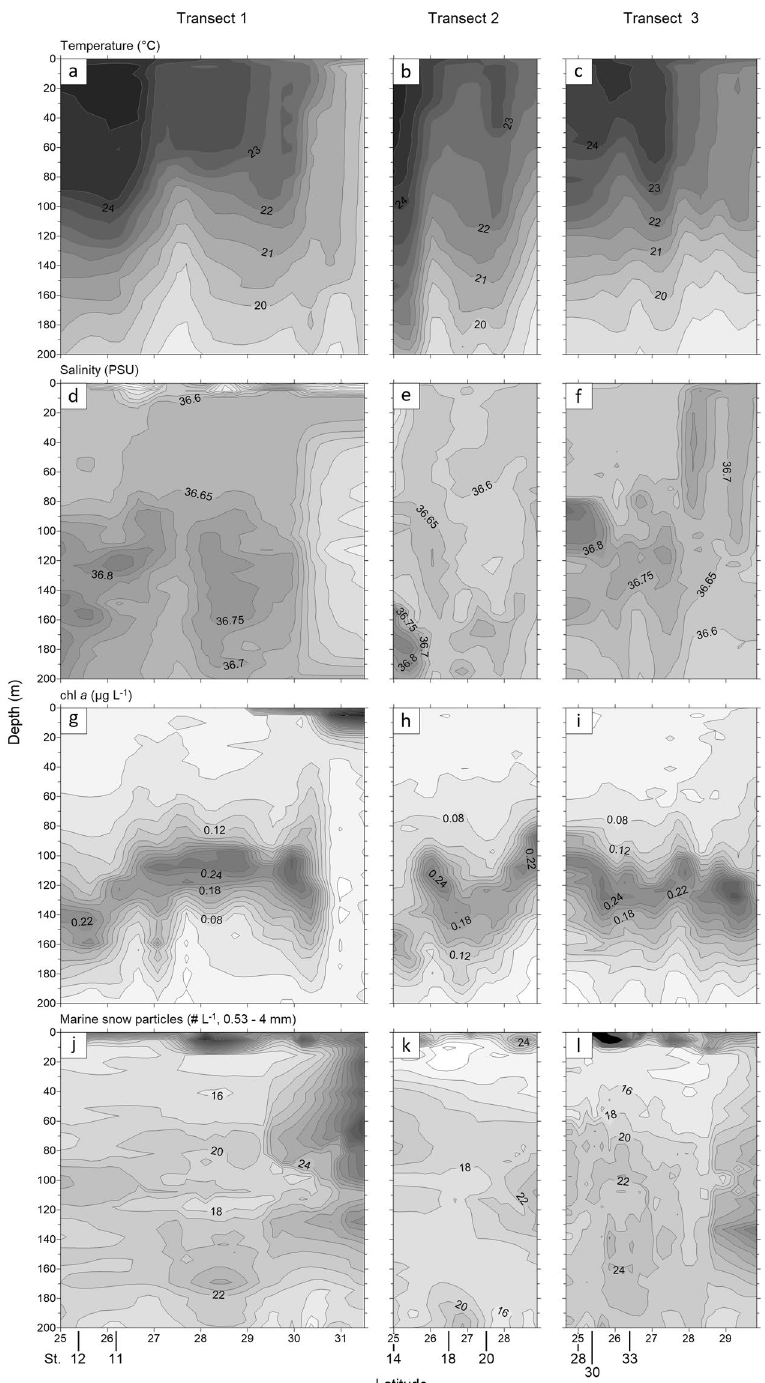
Figure 2. Temperature, salinity, chlorophyll a , and marine snow abundances (incl. Trichodesmium puffs) at Transect 1 (left column), Transect 2 (middle column), and Transect 3 (right column). ABC = Temperature (°C), DEF = salinity (PSU), GHI = chlorophyll a ( µ g L − 1 ), JKL = marine snow abundances (# L − 1 , 0.53–4 mm). Stations sampled for marine snow are indicated on the latitude axis of